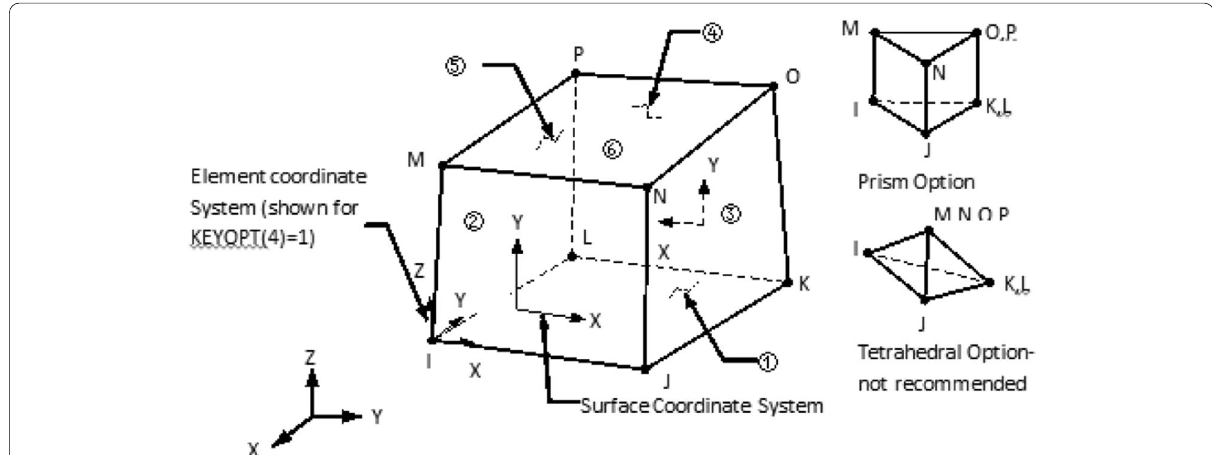
Fig. 10 Details of finite elements: SOLID45 [50]